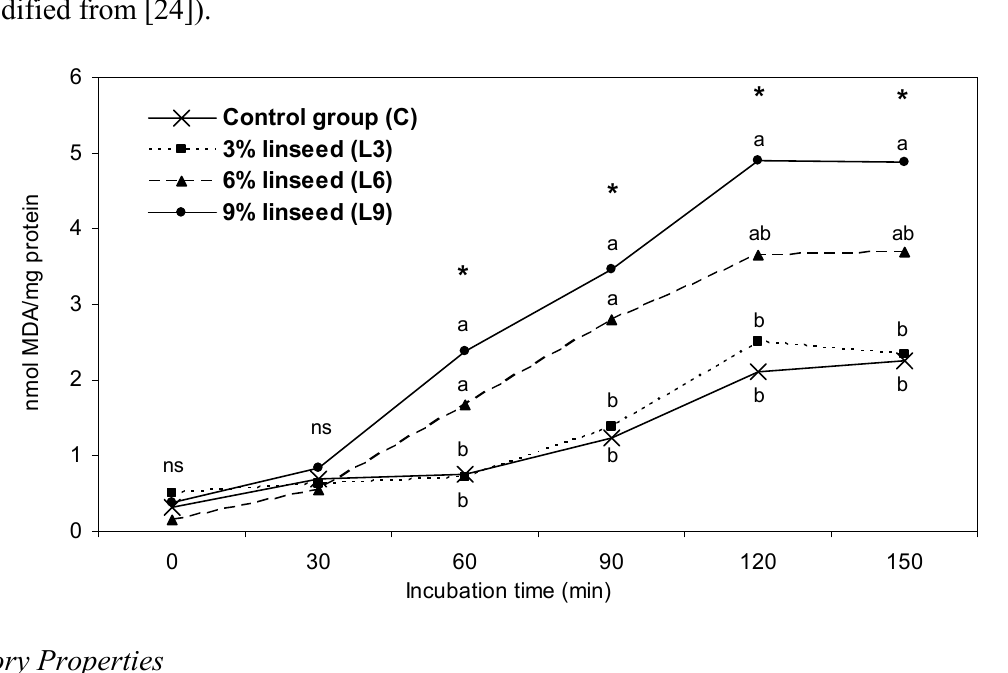
Figure 3. Influence of dietary linseed content on lipid susceptibility to oxidation (induced TBARS) (modified from